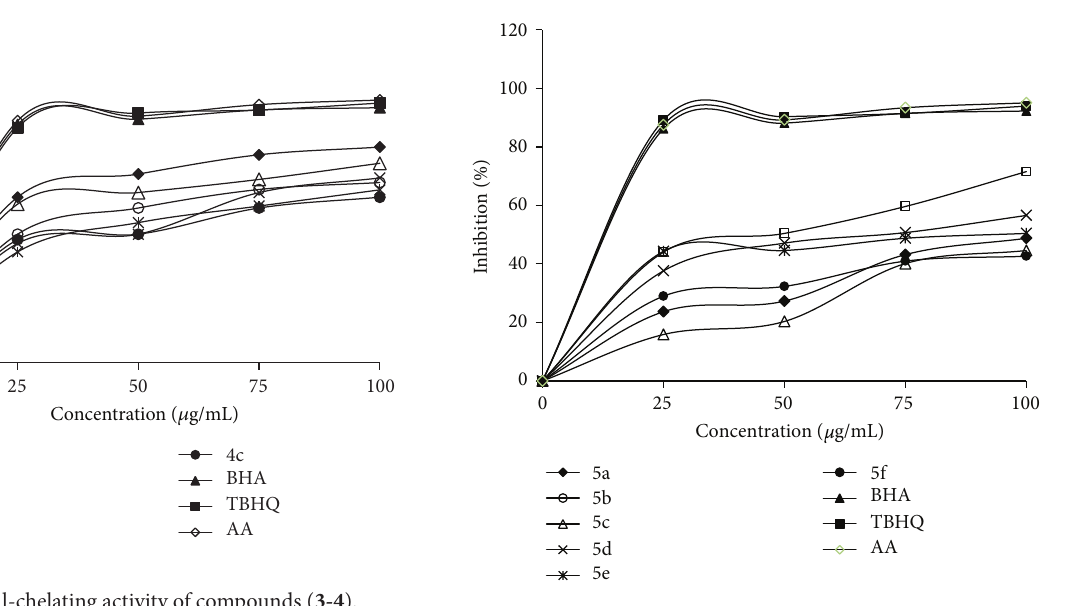
(0.01 mol) and 5-substituted 2-phenylindole-3-carboxalde- hyde (0.01 mol) in 1,4-dioxane (40 mL) containing